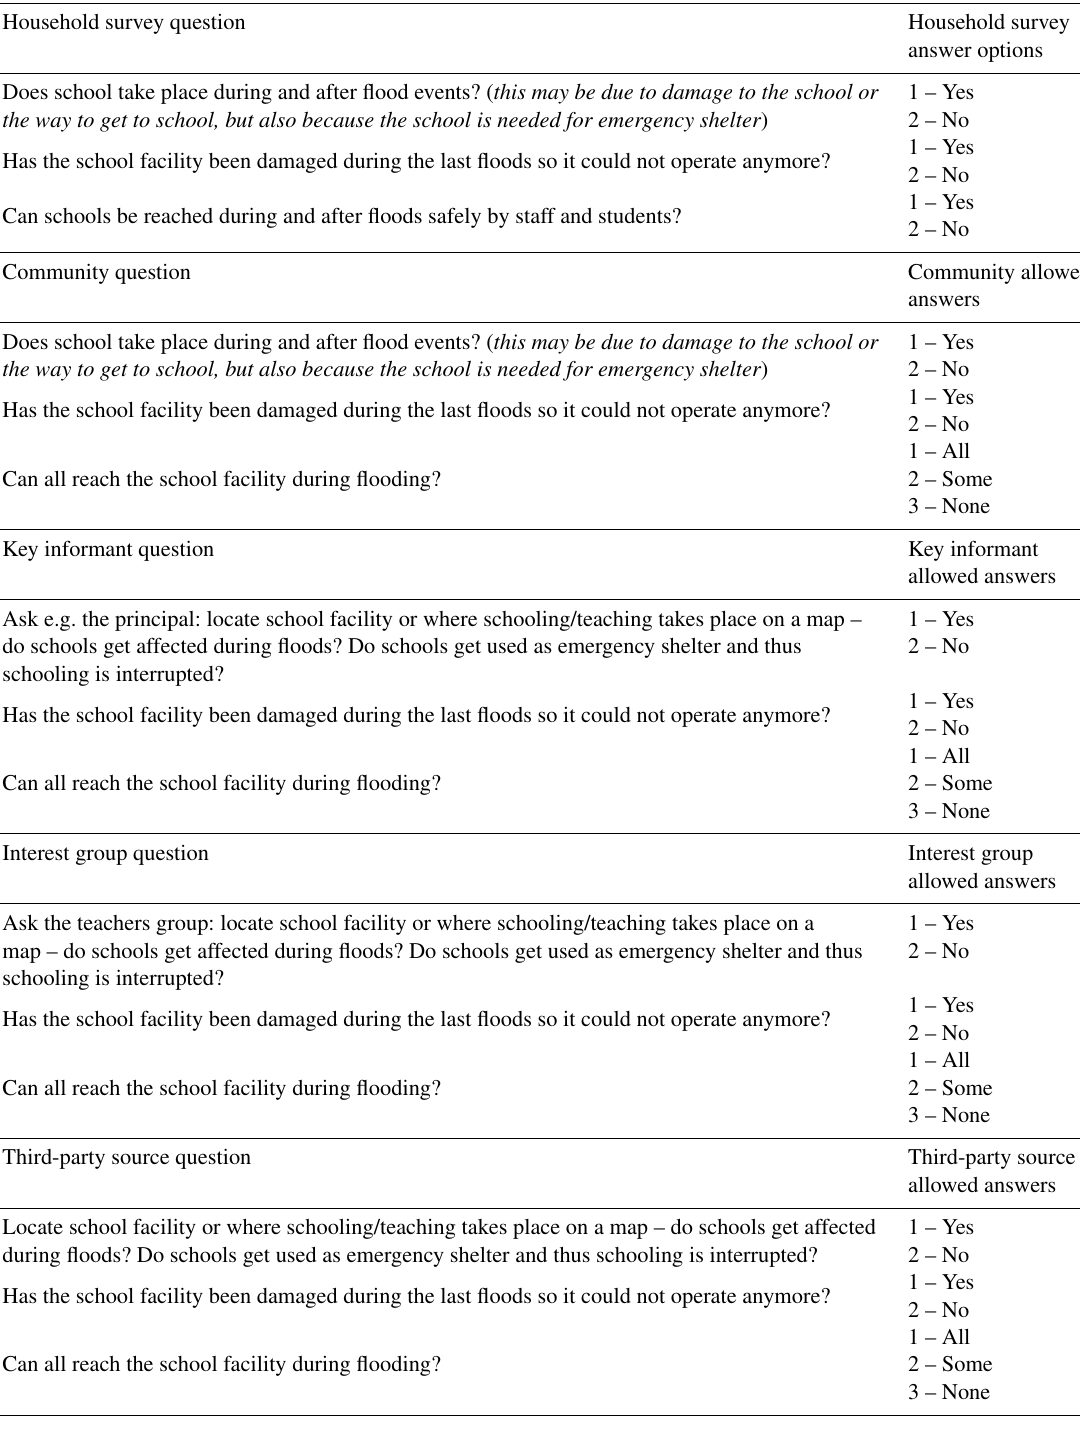
Table C1. Data collection questions and answer options for source “access to school